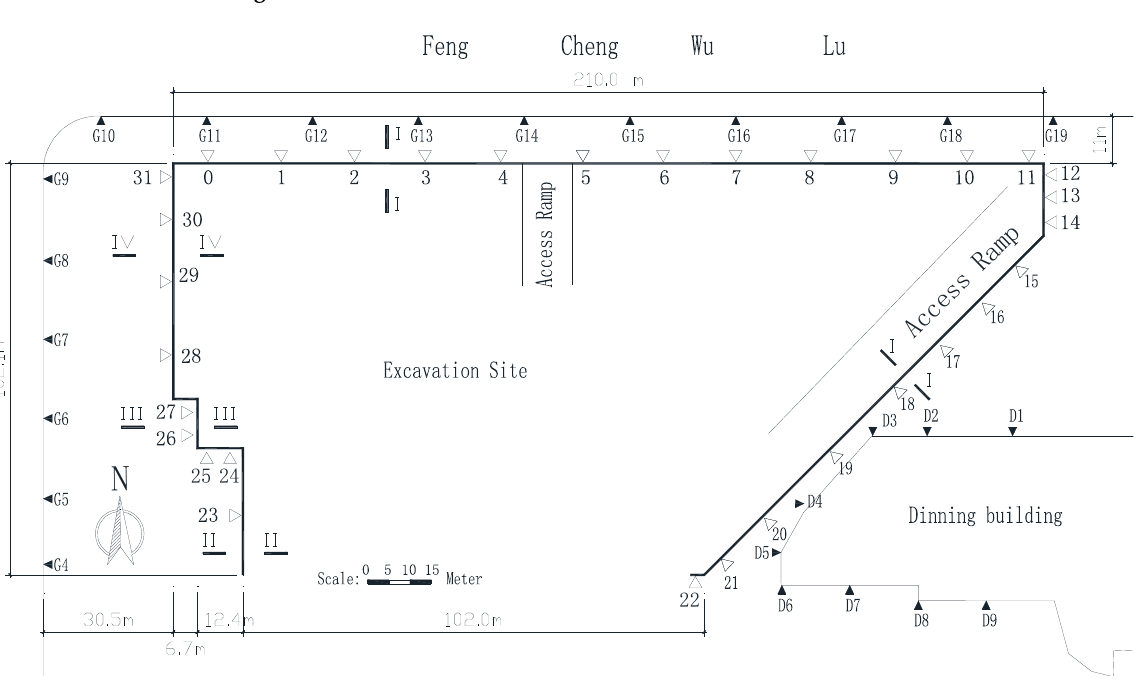
Figure 3. Layout of settlement and deflection monitoring points of excavation and adjacent